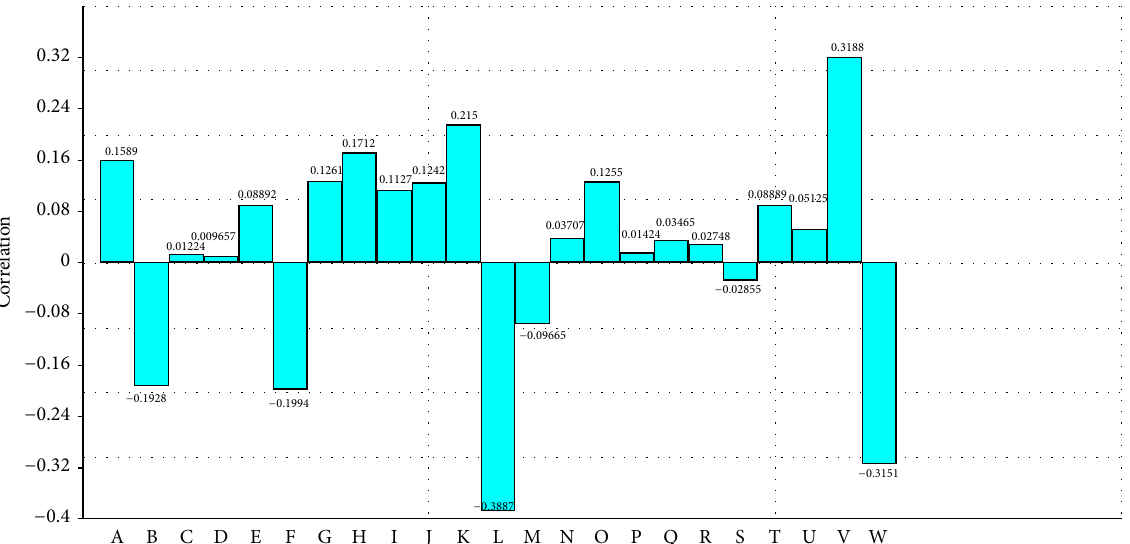
Figure 4: PCA loadings of PC 3 and its correlation with various morphometric